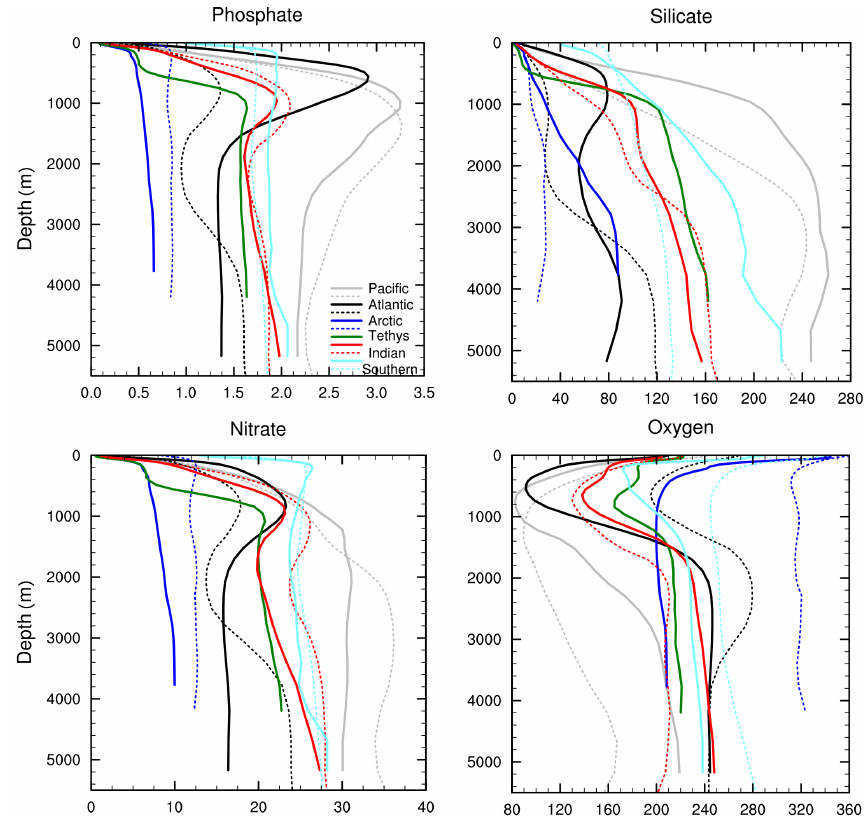
Fig. 8. Globally averaged vertical profiles of phosphate, silicate, nitrate and oxygen (all in µ mol L − 1 ). Solid lines show Late Paleocene distributions, dotted lines show pre-industrial concentrations calculated within CMIP5 experiments.